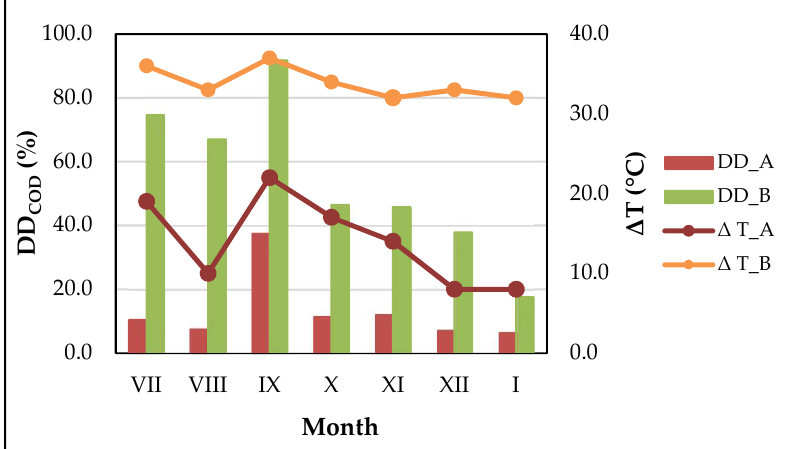
Figure 2. Evolution of disintegration degree (DD COD ) vs temperature increase ( ∆ T) of waste activated sludge (WAS).